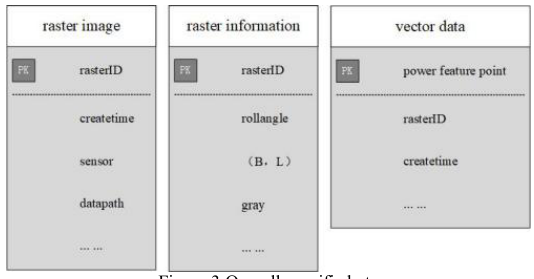
Figure 3.Overall specific byte